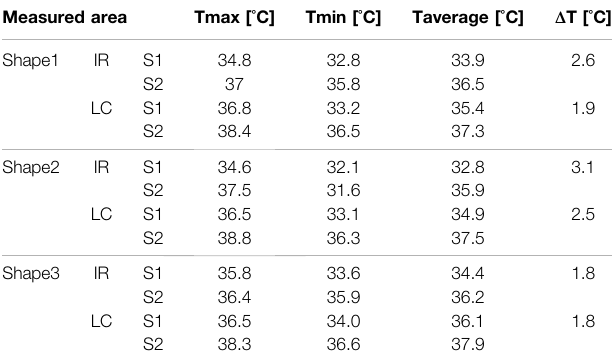
TABLE 5 | Comparison between temperature measurements using LCs patches and application against the ones measured using IR imaging. Measured